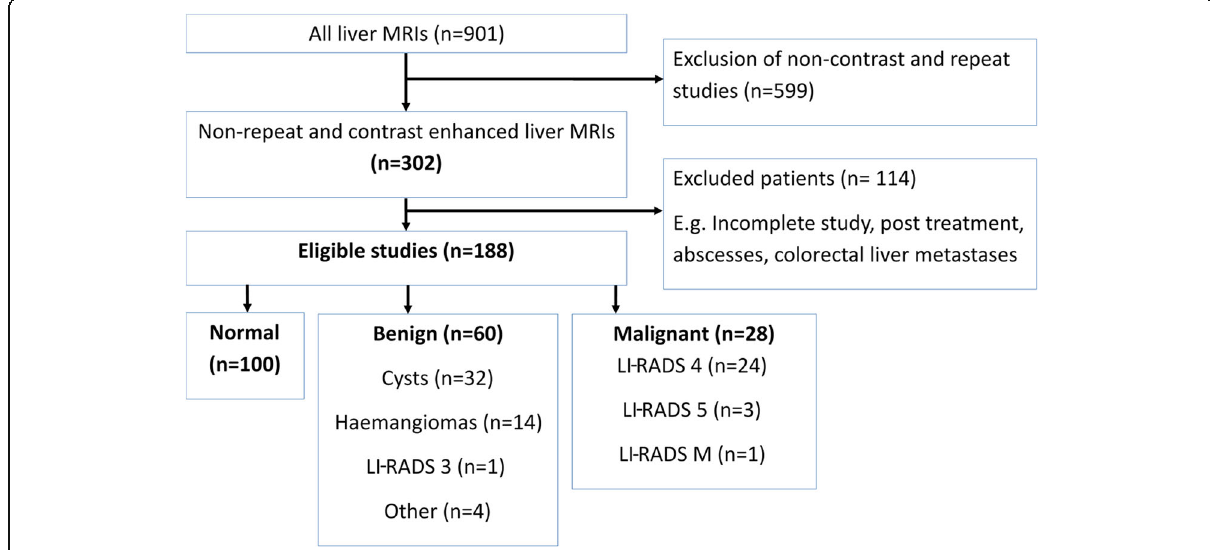
Fig. 4 Flow chart of study